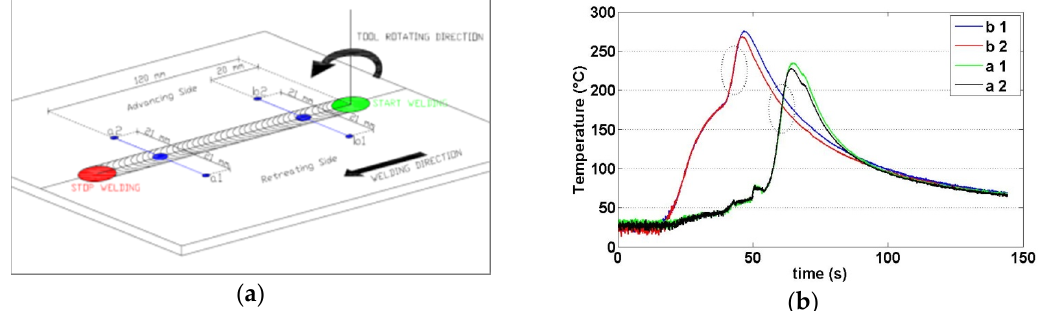
Figure 13. ( a ) Positioning of the measurement points along the welding line, used for the analysis of MSHC; ( b ) Thermal profile obtained for points a1, a2, b1 and b2 (Test R1T3).